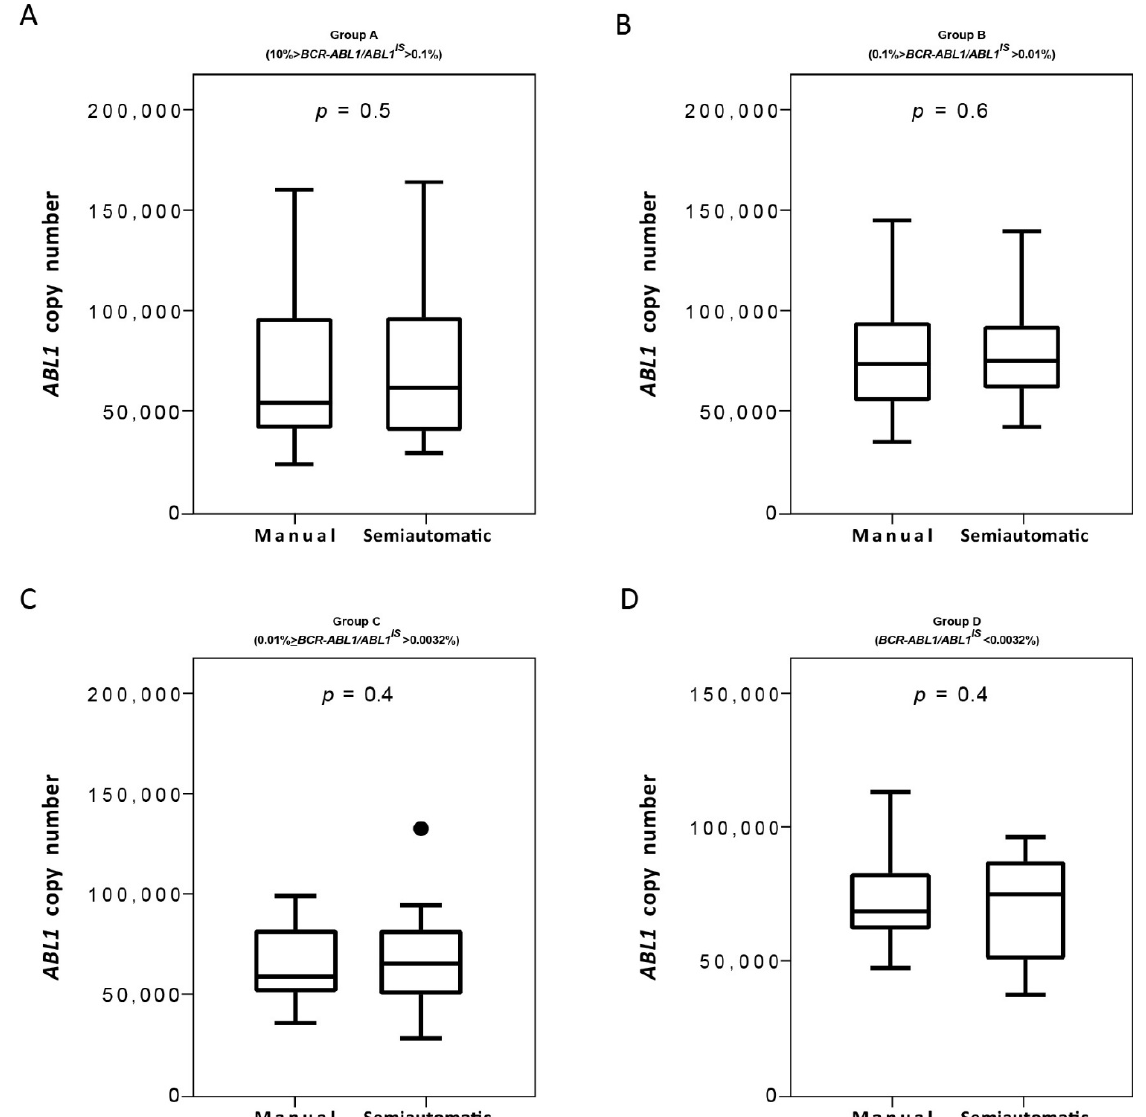
Figure 6. Measurement of ABL1 control gene on samples processed with the manual and semiautomatic protocols . Molecular measurement of ABL1 transcripts levels by Q-PCR of matched blood samples processed with a manual or a newly semiautomatic method. ABL1 reference gene copies were measured the four groups of patients stratified, each consisting of 25 subjects: Group A (10% > BCR-ABL1/ABL1 IS > 0.1%) ( A ), Group B (0.1% > BCR-ABL1/ABL1 IS > 0.01%) ( B ), Group C (0.01% > BCR-ABL1/ABL1 IS > 0.0032%) ( C ) and Group D ( BCR-ABL1/ABL1 IS < 0.0032%) ( D ). ABL1 levels were determined for each method and depicted as boxplots delimited by the 25th (lower) and 75th (upper) percentile. Horizontal lines above and below each boxplot indicate the 5th and 95th percentile, respectively. Thick lines in each boxplot represent median ABL1 in each patient group. The Wilcoxon signed-rank test was used to test the difference between the platforms. The symbol ● indicate the manual and the semiautomatic method, respectively. p value below 0.5 was considered statistical significant.